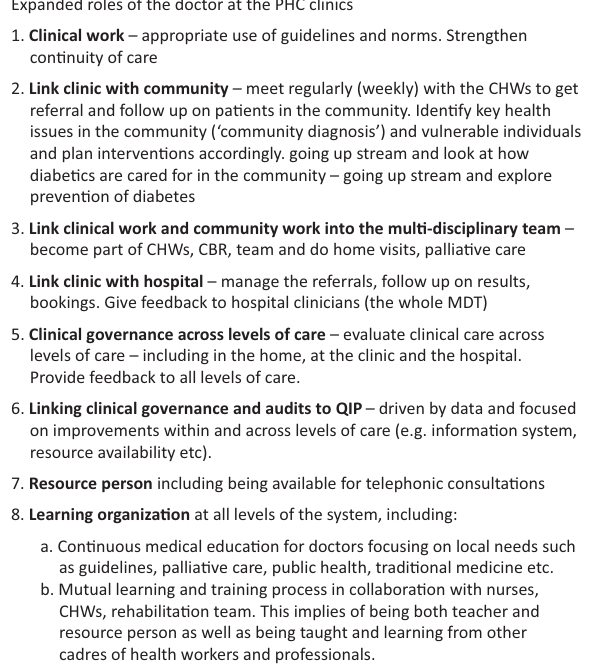
Expanded roles of the doctor at the PHC